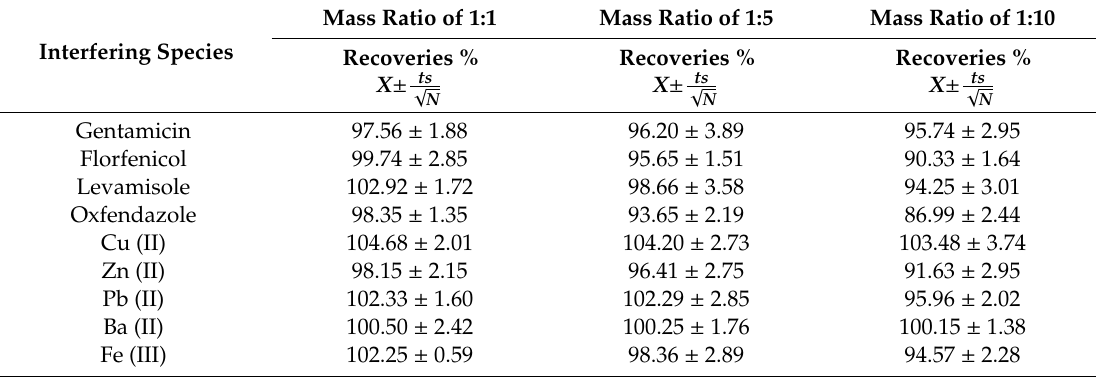
Table 2. E ff ect of interfering species on the determination of oxyclozanide anthelmintic drug ( N = 3).